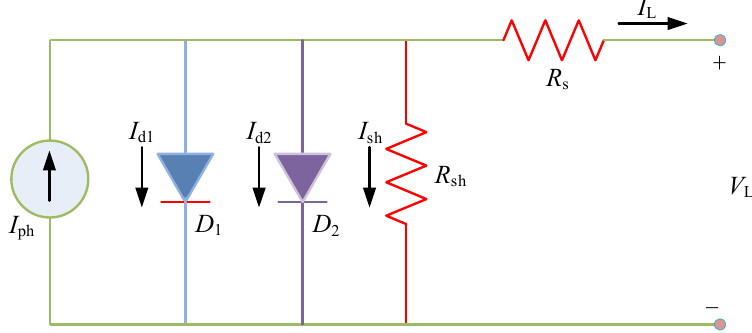
Figure 1. Double diode model.